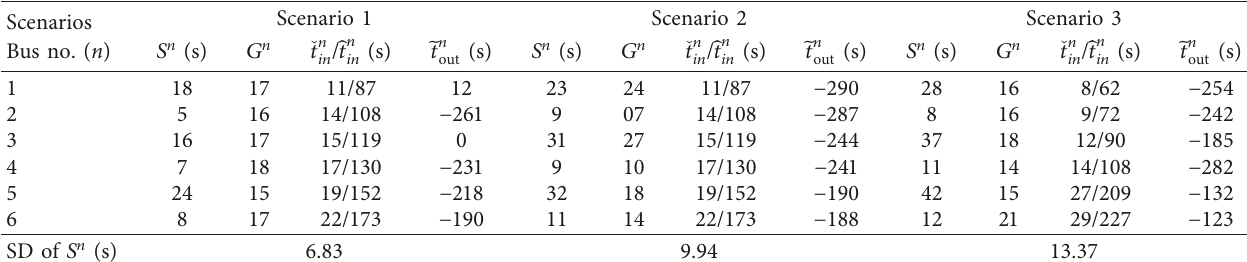
Table 2: Parameter settings in three static